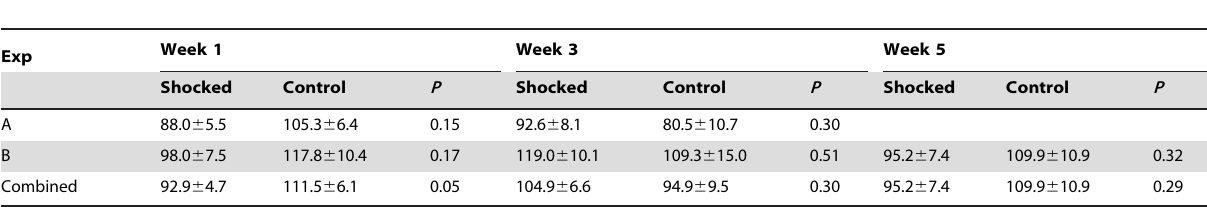
Table 2. Accumulated time (sec) spent in the bright chamber out of a 5 min test period in the light/dark